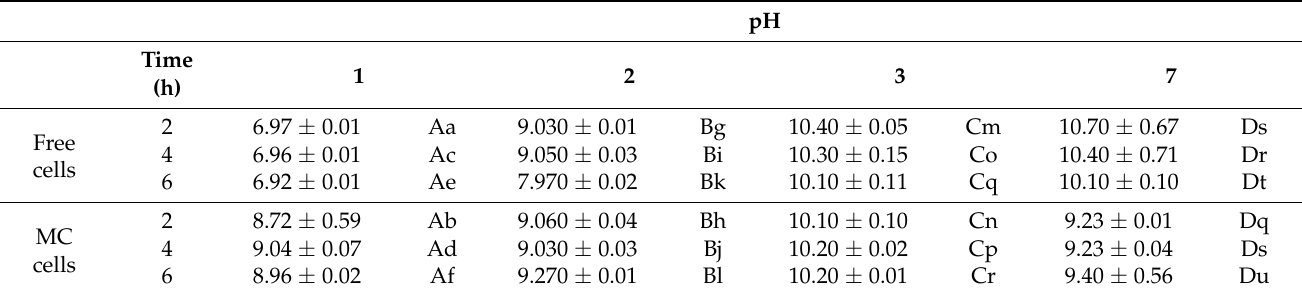
Table 3. Effect of pH on the viability of free and microencapsulated (alginate+xanthan gum) L. rhamnosus microcapsules (log cfu mL − 1 ).